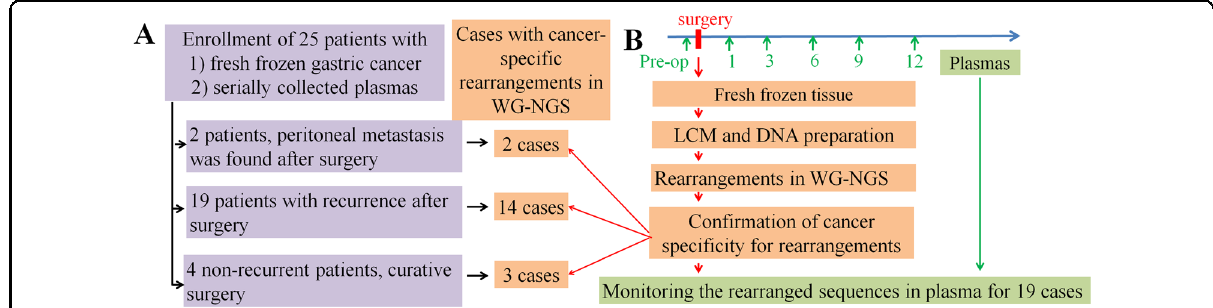
Fig. 1 Study scheme. a Cases included in the present study. b Methodological procedure of the present study. DNA was prepared after laser-capture microdissection (LCM). Rearranged sequences were analyzed from WGS and were con fi rmed by PCR sequencing. The presence of ctDNA